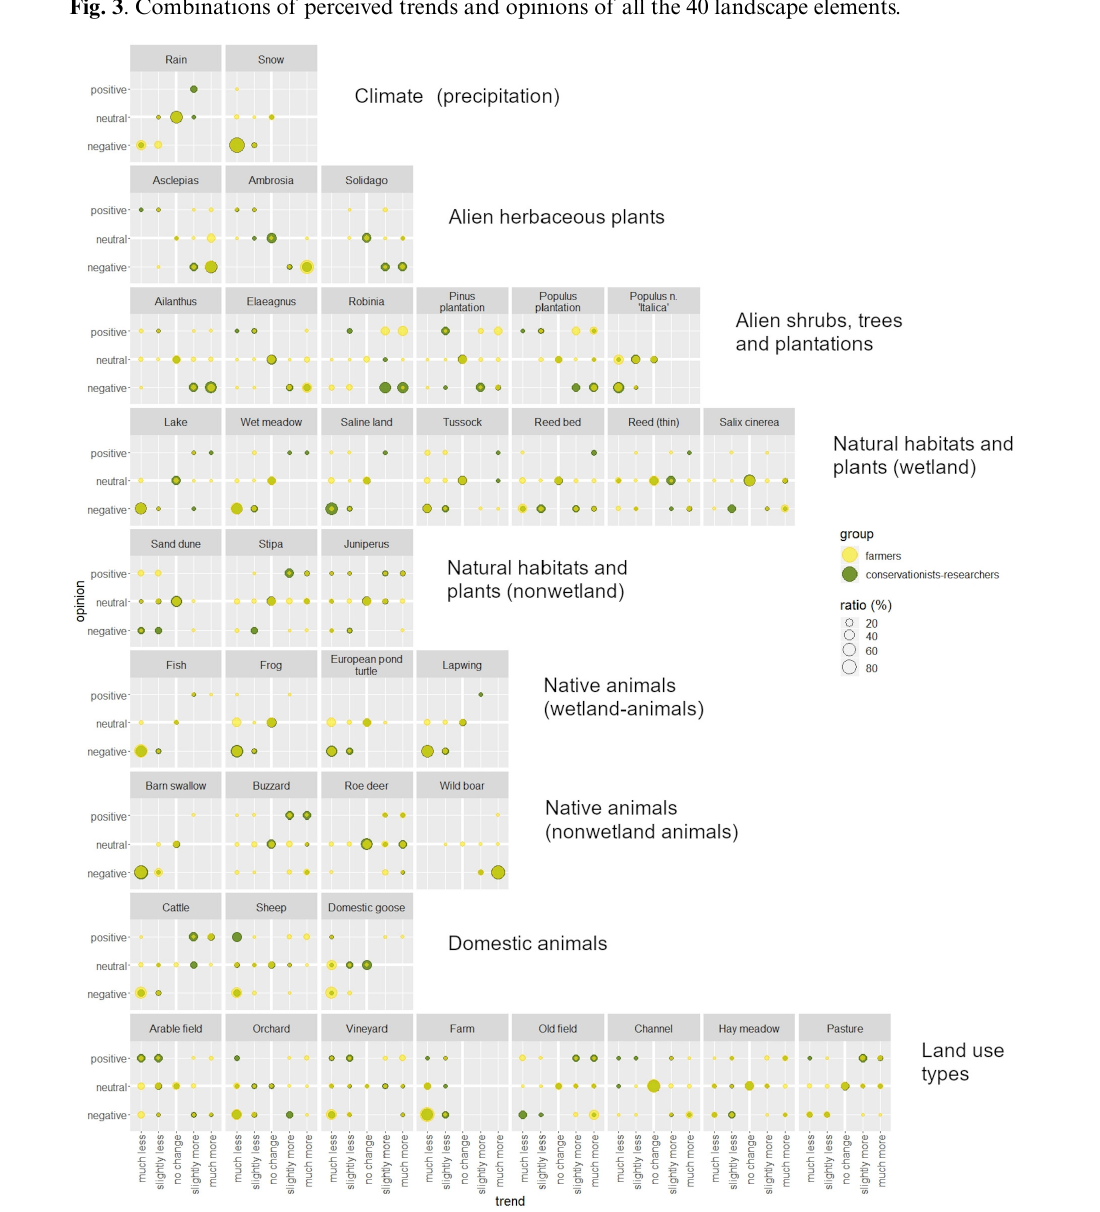
Fig. 3 . Combinations of perceived trends and opinions of all the 40 landscape